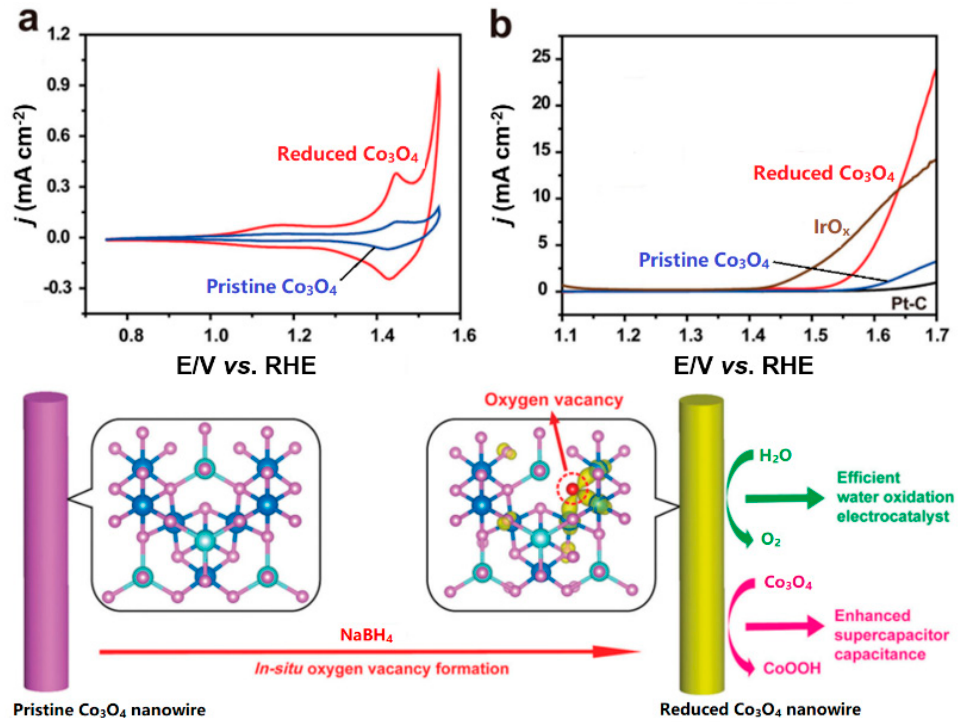
Figure 14. ( a ) Cyclic voltammograms of reduced Co 3 O 4 , and pristine Co 3 O 4 NWs deposited on glassy carbon electrodes in O 2 -saturated 1 M KOH at 5 mV s − 1 ; ( b ) water oxidation current-potential characteristic of reduced Co 3 O 4 NWs (red curve), pristine Co 3 O 4 NWs (blue curve), IrO x (brown curve) and Pt/C (black curve) in O 2 -saturated 1 M KOH at a scan rate 5 mV s − 1 at 1600 rpm (anodic sweep) at 25 ± 1 °C with iR -compensation. The catalyst mass loadings in all cases was 0.136 mg cm − 2 ; The bottom panel shows the ins situ chemical reduction via NaBH 4 to form oxygen vacancies in Co 3 O 4 NWs. Reproduced from [143], Copyright © Wiley, 2014.